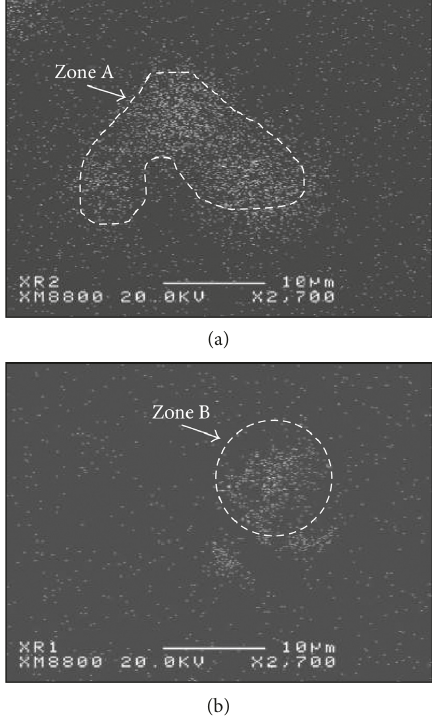
Figure 15: Distribution of (a) B and (b) Si in the 800ppm B-treated Al-7%Si alloy shown in Figure